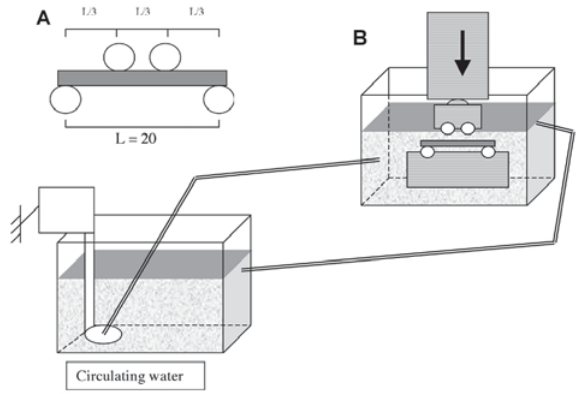
FIGURE 4- ( A ) Schematic representation of the four-point flexure test arrangement. The outer span length (L) is 20 mm, and the inner span is L/3. ( B ) Four-point flexural loading arrangement in 37 0 C distilled water (top right) provided by a circulating water bath (bottom left). This test method simulates the service environment. Adapted from Della Bona, et al. 19 ,